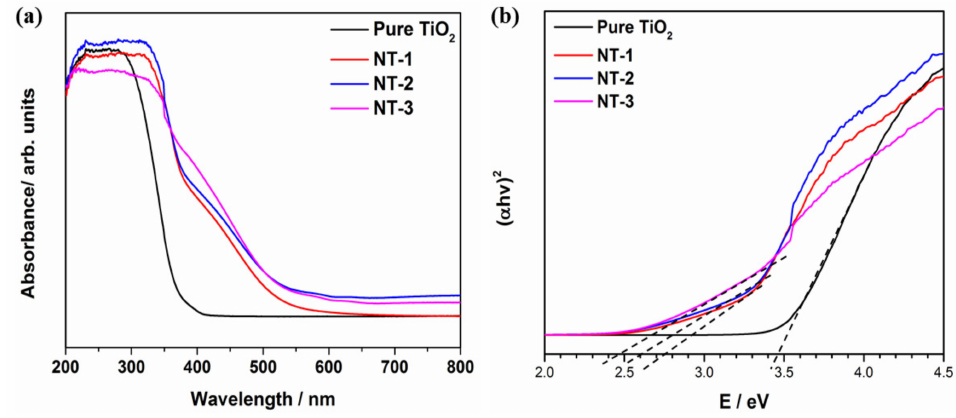
Figure 6. ( a ) UV Vis DRS spectra, and ( b ) Band gap estimation of, Pure TiO 2 , NT-1, NT-2 and